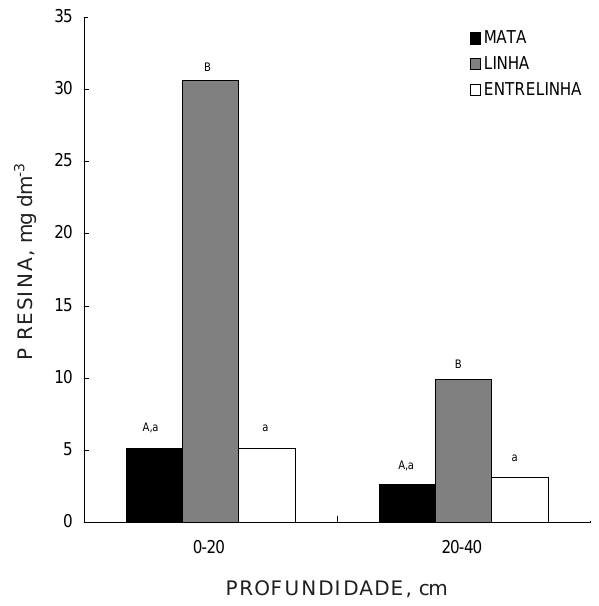
Figura 3. Valores médios de P, nas profundidades de 0-20 e 20-40 cm, para os três locais estudados. As letras maiúsculas comparam as áreas sob mata e a linha da cultura, a 5% pelo teste t. As letras minúsculas comparam a mata e a entrelinha da cultura, a 5% pelo teste t.